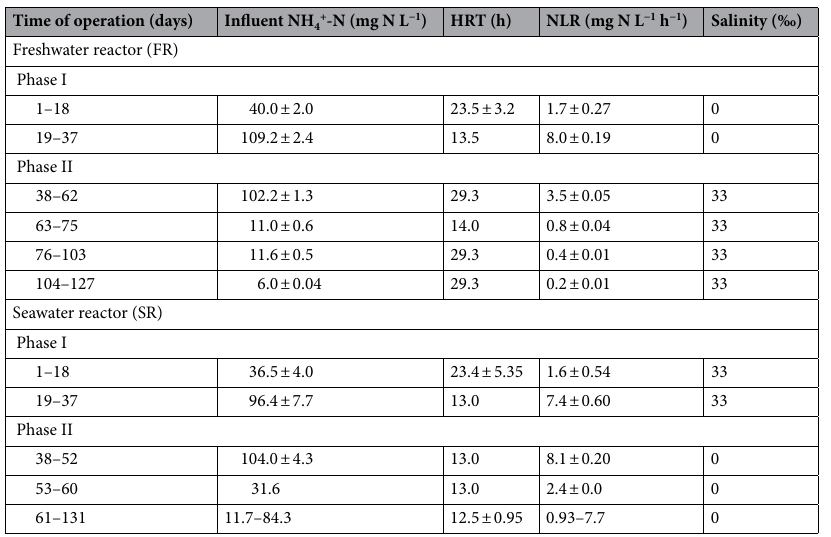
Table 1. Experimental conditions for freshwater (FR) and seawater (SR) reactors. HRT hydraulic retention time, NLR nitrogen loading